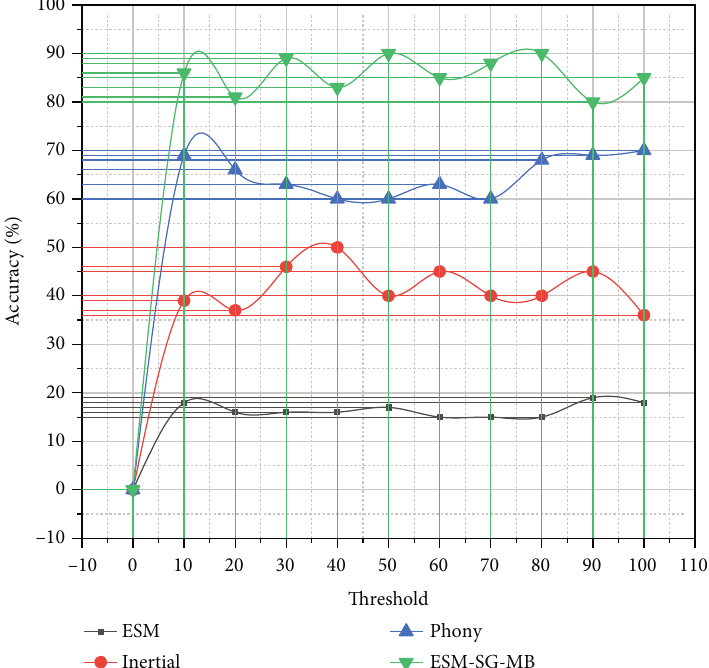
Figure 4: Comparison of algorithm accuracy.